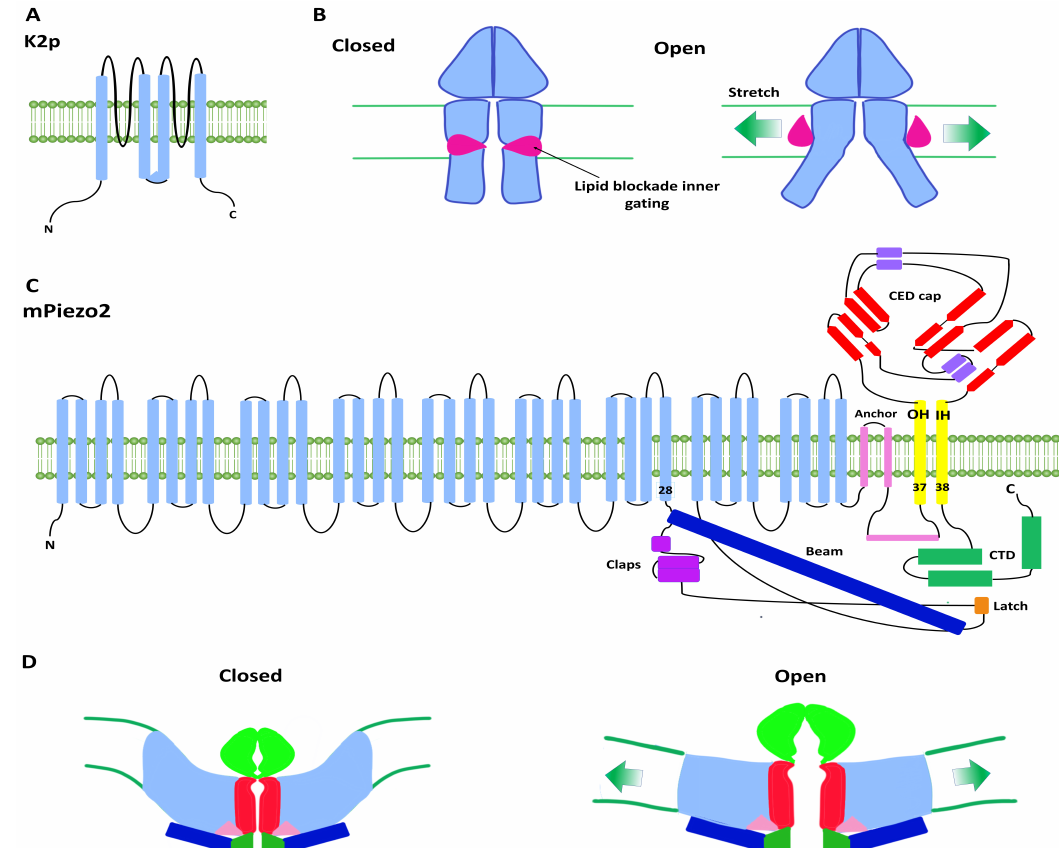
Figure 3. Two Pore domain Potassium channels (K2P) and Piezo channels structure and gating. ( A ) Schematic diagram of K2P monomers. K2P channel monomers have four transmembrane domains (light blue) and two pore-forming regions (in black). They assemble in tetramers to form potassium channels such as the mechanosensitive TREEK-1/2 and TRAAK (adapted from [3]). ( B ) Model of mechanosensitive K2P gating. Mechanosensitive K2P channels rely on the force-from-lipid model to sense mechanical stimuli. The channel opens in response to membrane stretch thanks to its direct interaction with membrane lipids (fuchsia) (adapted from [67]). ( C ) Cartoon representation of mouse Piezo2 channel monomers. Piezo2 channels are predicted to have up to 38 transmembrane domains [3]. In addition to the transmembrane domains, Piezo channels possess also a C-Terminal-Extracellular domain (CED) that constitutes the central dome, as well as a beam and an anchor that connect the central pore of the channel with the mechanotransduction module (adapted from [68]). ( D ) Model of Piezo channel gating. Piezo channels assemble in homotrimeric structures that sense the stretch of the lipid bilayer (adapted from